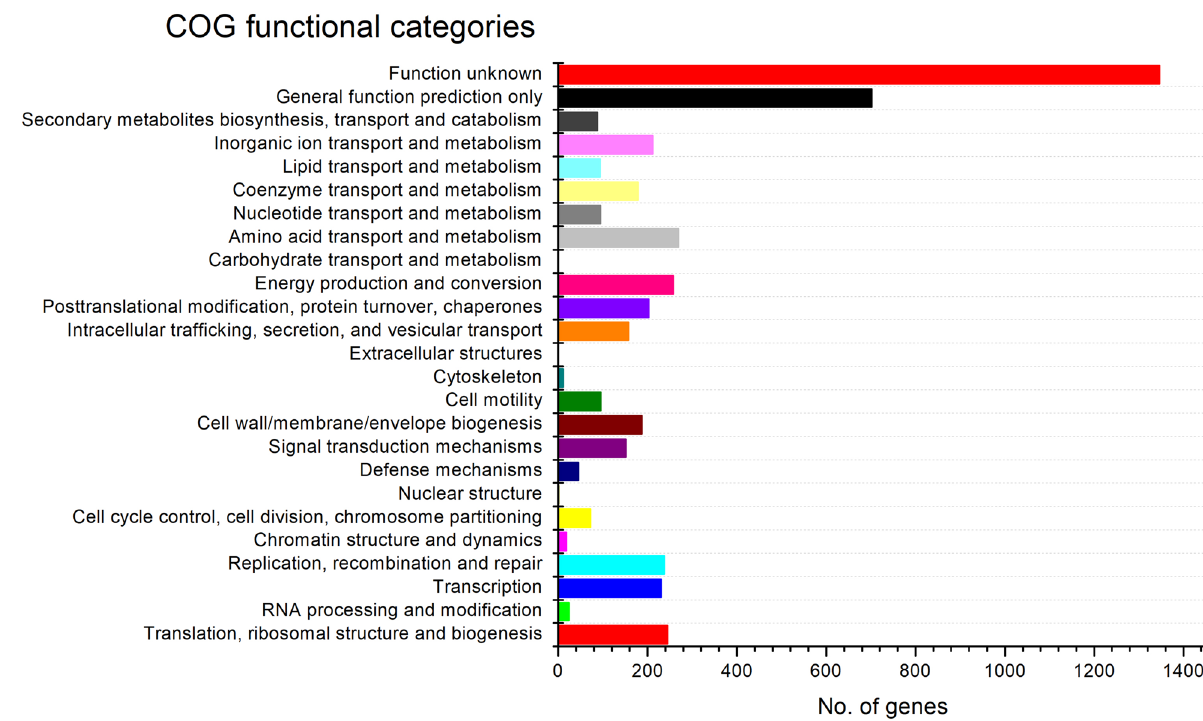
Figure 4. COG functional classification of proteins in the genome of strain TW-1 T .